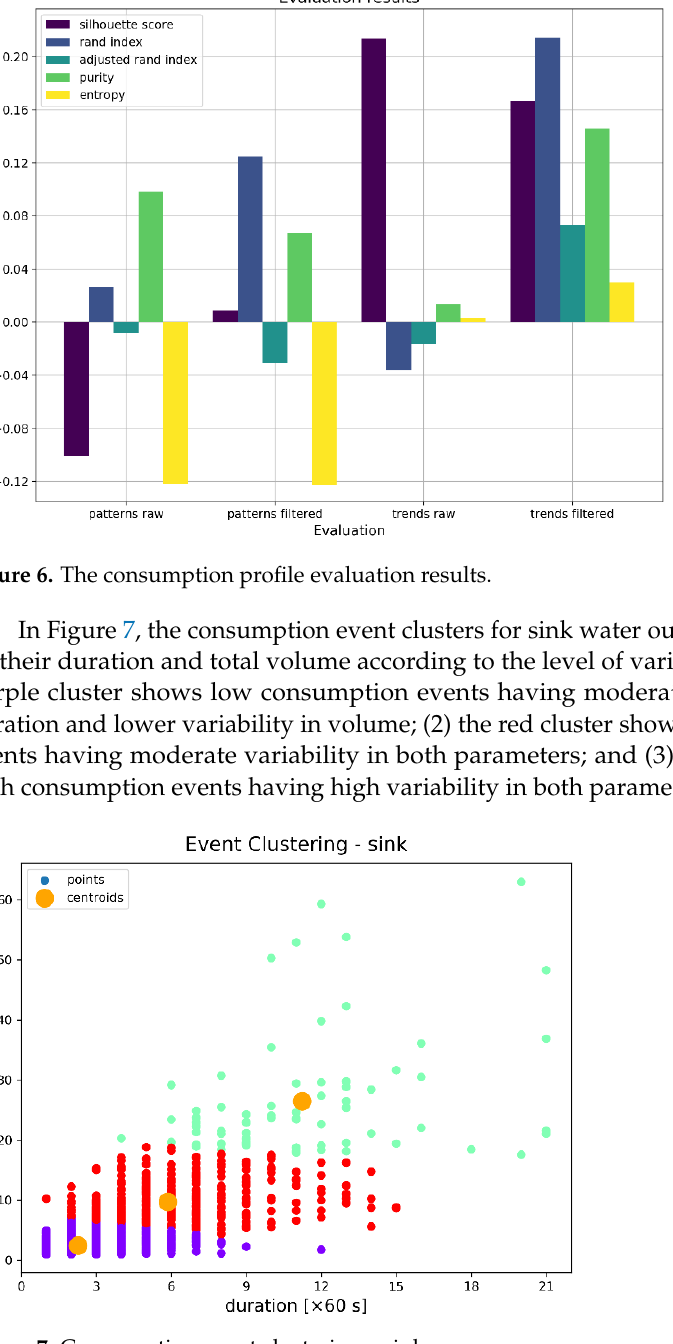
Figure 8. Consumption event clustering — toilet. In Figure 9, the consumption event clusters for shower water outlet can be character- ized by their duration and total volume, according to the level of variability as follows: (1) the green cluster represents low consumption events having low variability in terms of